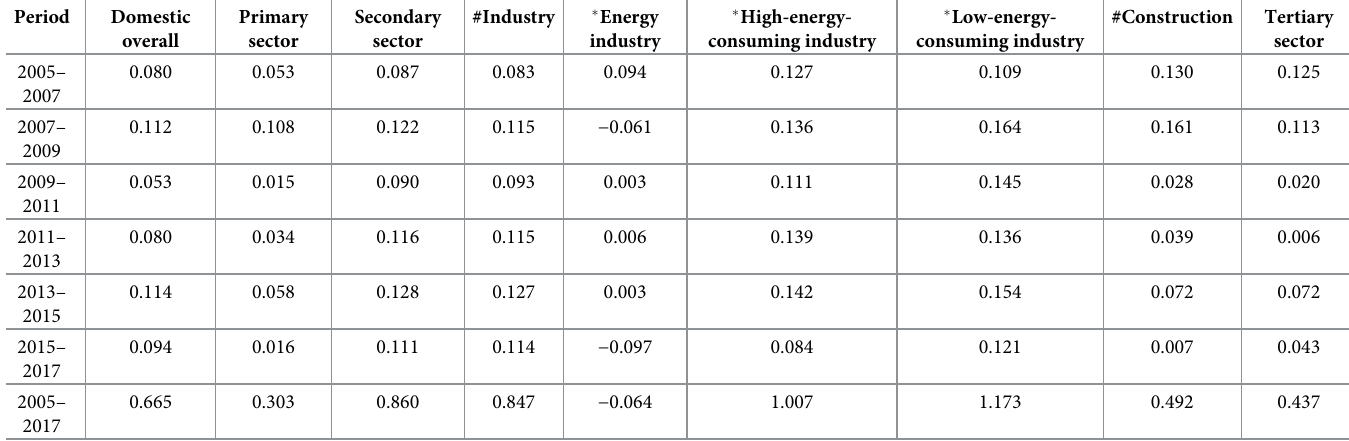
Table 4. The DEI of the domestic overall, primary, secondary, and tertiary sectors, and various industries within the secondary sector during 2005–2017. Period Domestic